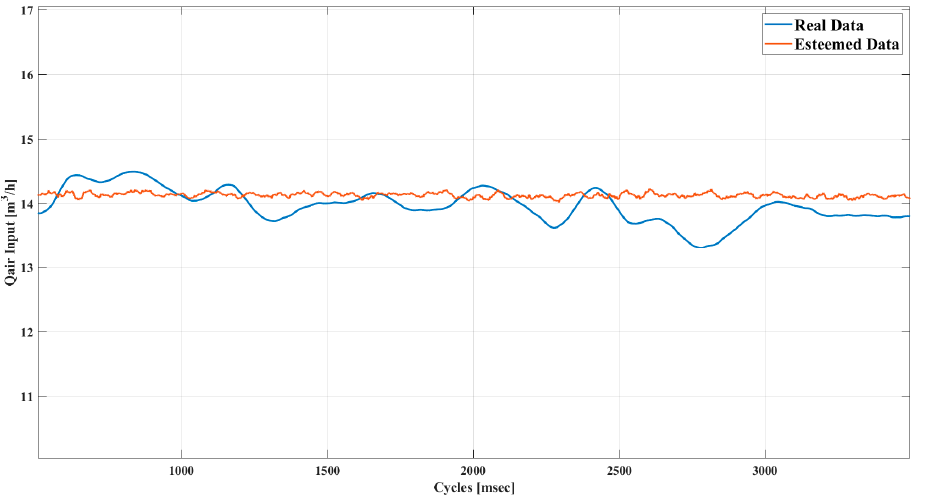
The t -test returns an evaluation on the null hypothesis that the estimated data origi-